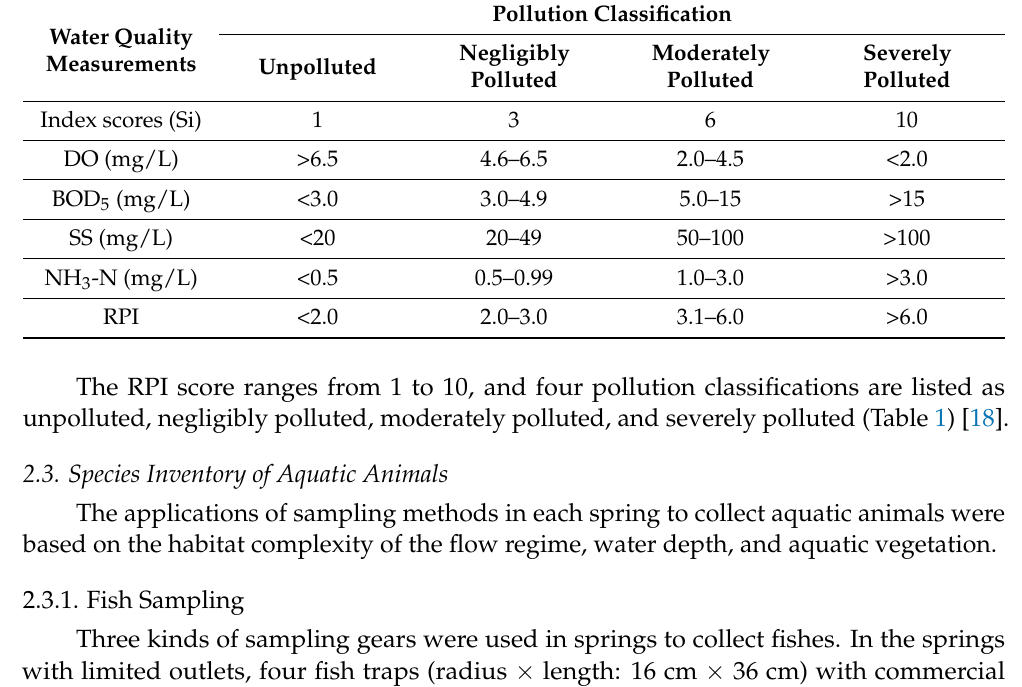
Table 1. Definition of River Pollution Index